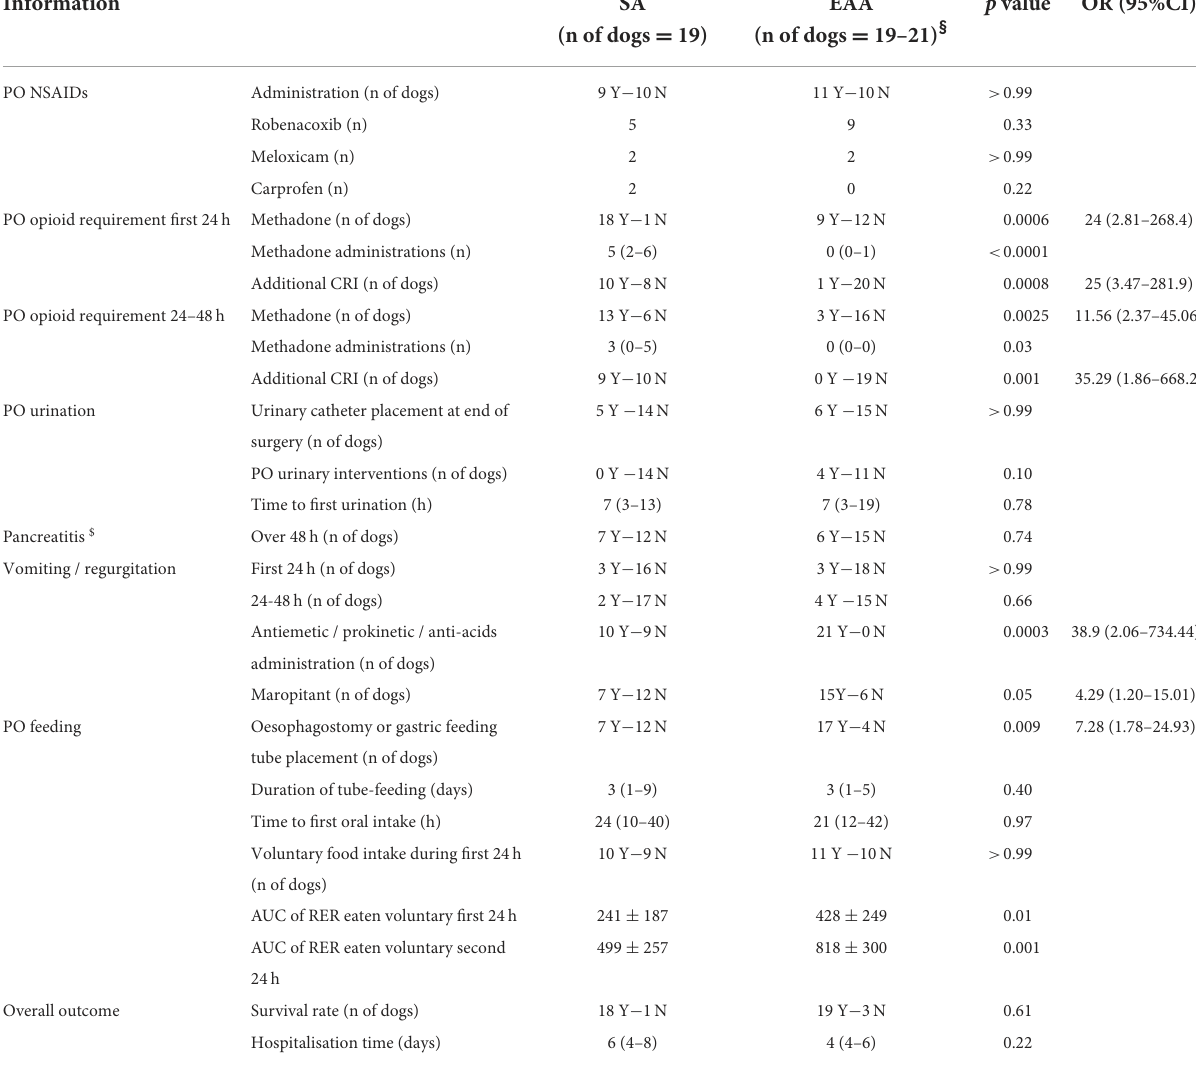
TABLE 5 Postoperative information recorded from a cohort of dogs undergoing cholecystectomy and in which systemic analgesia (SA) or extradural anaesthesia-analgesia (EAA) were used.